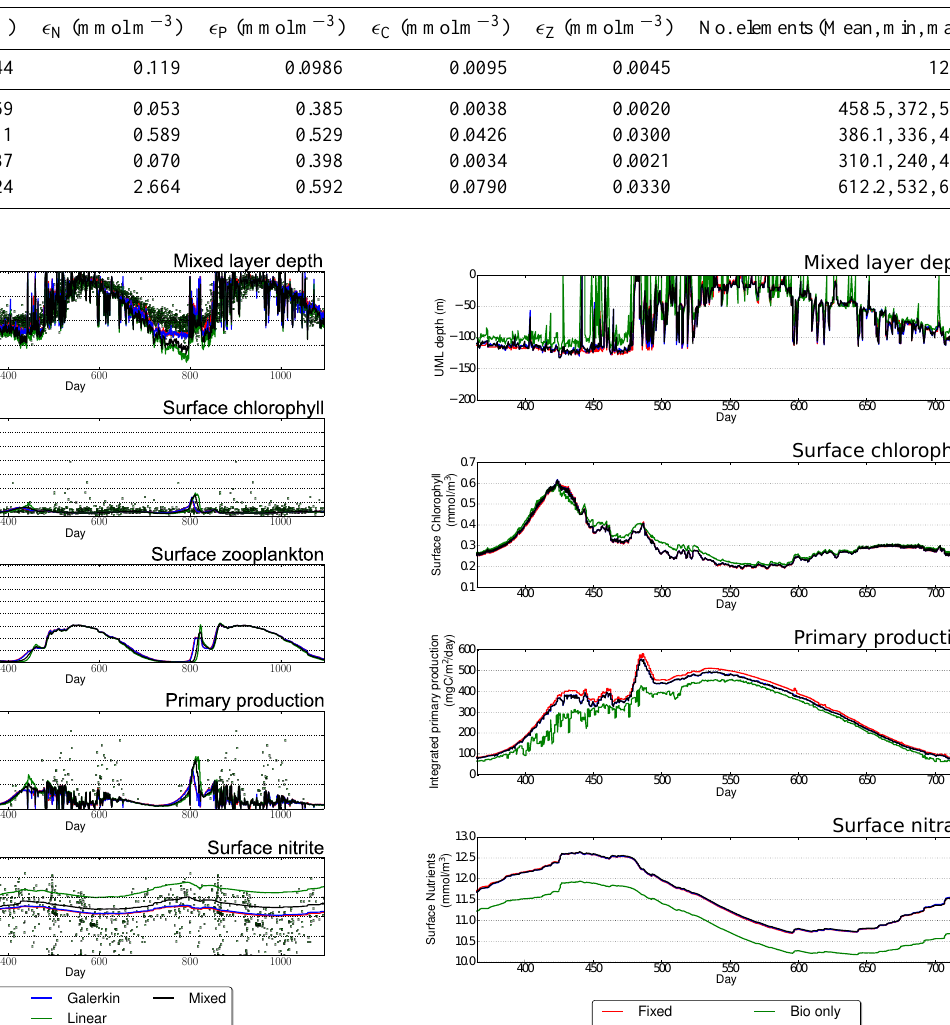
Fig. 11. Summary of simulation results from Station Papa compar- ing the fixed high-resolution (2.5m) simulation with adaptive sim- ulation using different interpolation methods between meshes. Lin- ear and mixed perform poorly, inducing extra vertical diffusivity, compared to Galerkin projection. Panels and data are the same as in Fig. 6.